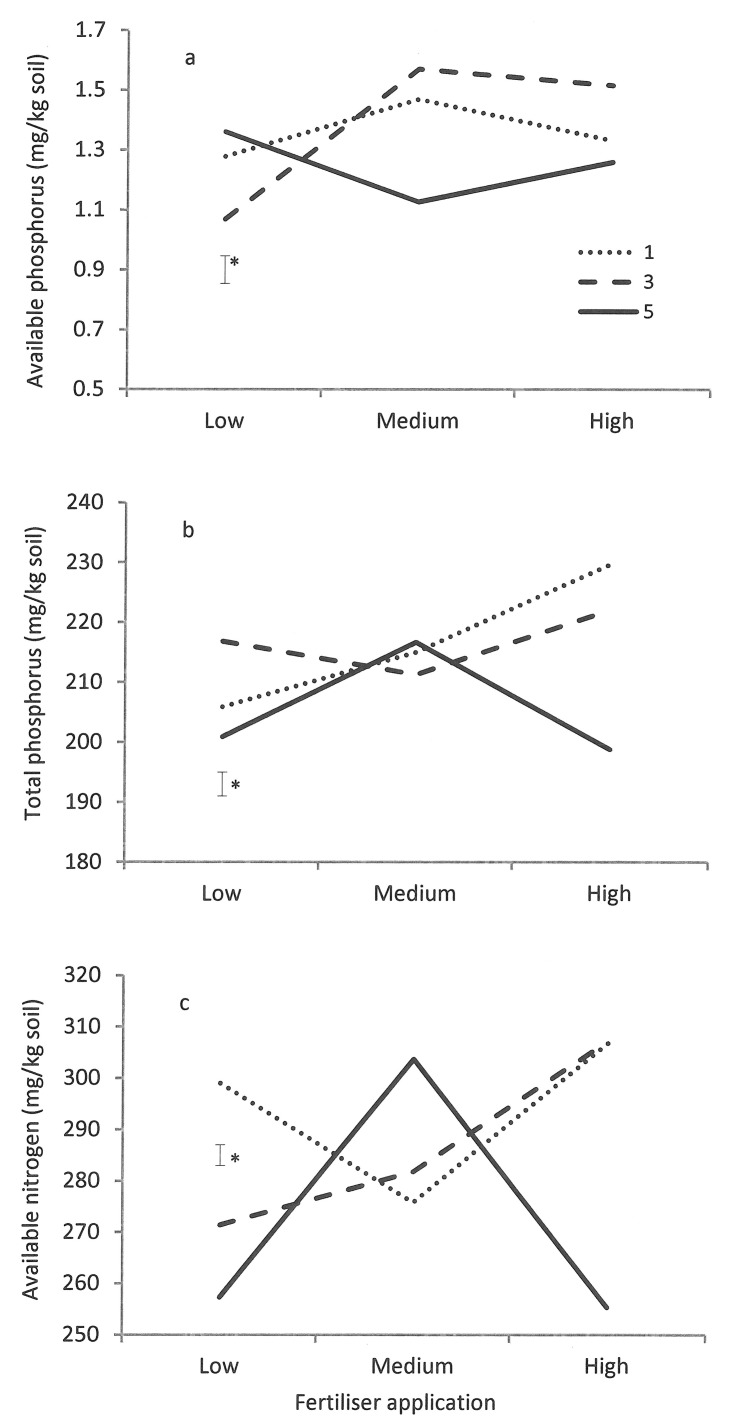
Interactions between defoliation regimes (cut to 1, 3 and 5 cm above ground) and phosphorus application (low, medium and high) on (a) effective and (b) total phosphorus and (c) effective nitrogen in the soil.Bars represent the standard error of the mean; *P < 0.05.